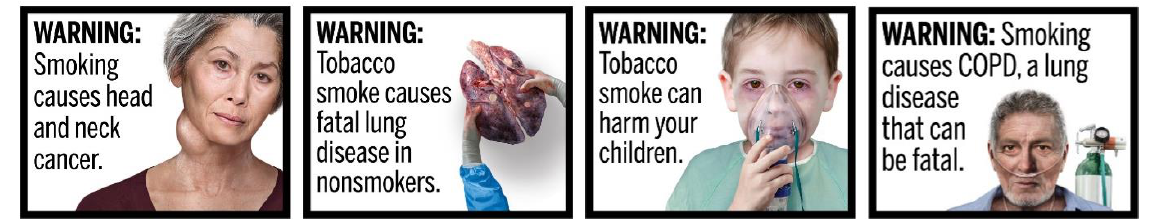
Figure 3. Examples of the cigarette labels proposed in 2019 [43].